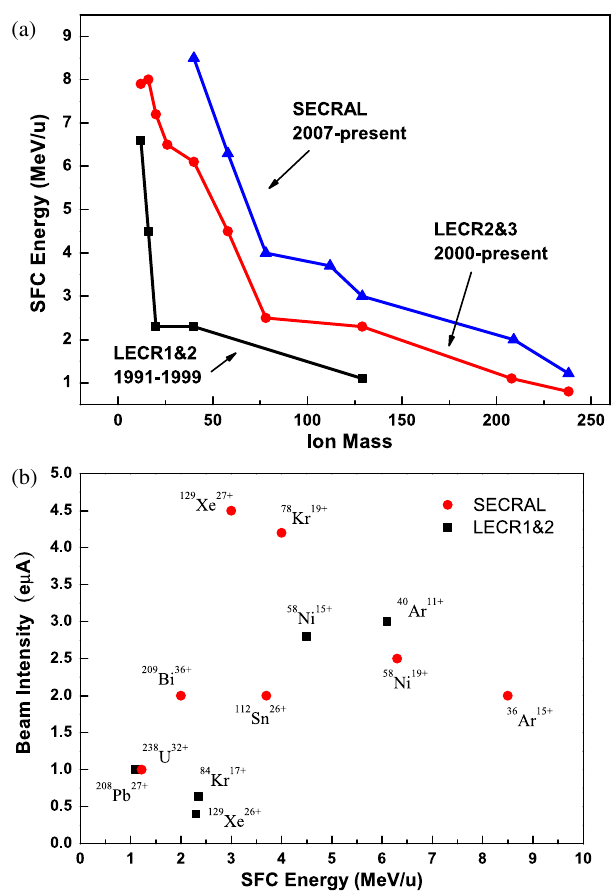
FIG. 29. Enhancement of SFC cyclotron beam energy and beam intensity due to SECRAL operation. (a) SFC beam energy improvement by SECRAL compared with the normal conducting ECR ion sources LECR0&1 and LECR2&3. (b) Enhancement of SFC beam intensity and energy by SECRAL compared with the normal conducting ECR ion sources LECR2&3.